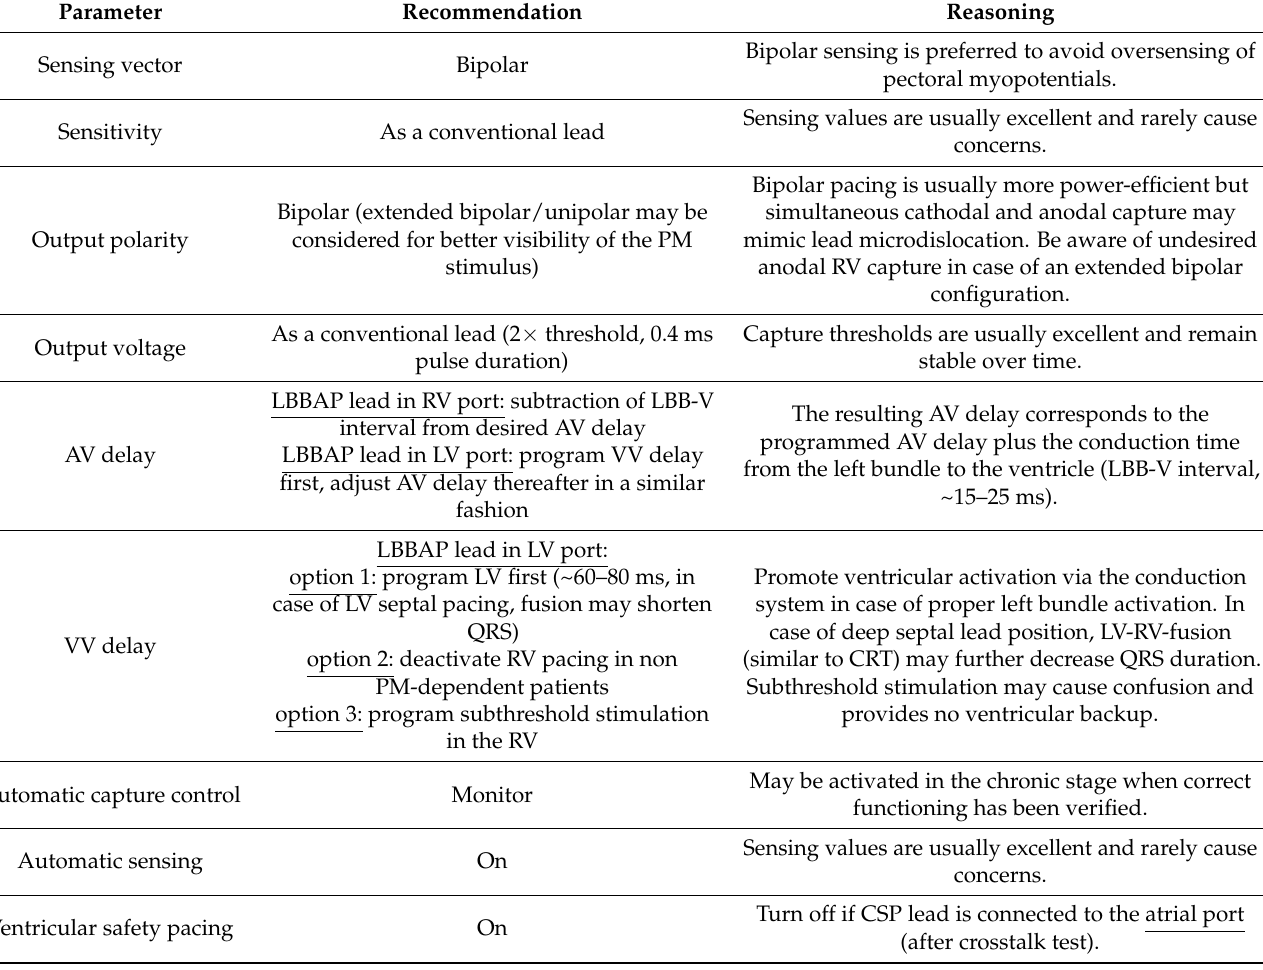
Table 1. LBBAP programming recommendations for systems with a CSP lead in a ventricular